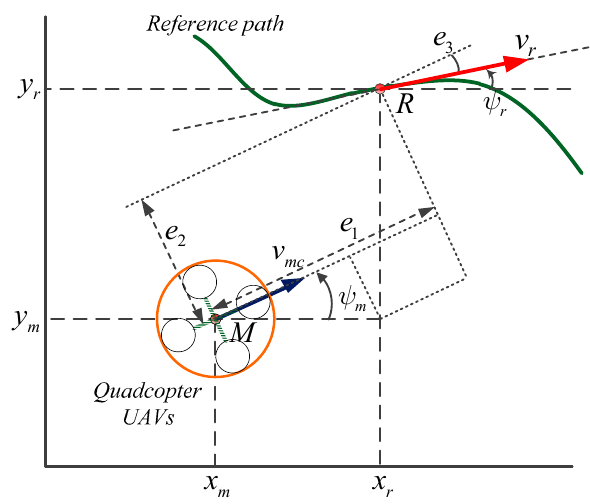
Figure 2. The geometry of describing the kinematic equation of the quadcopter and the reference